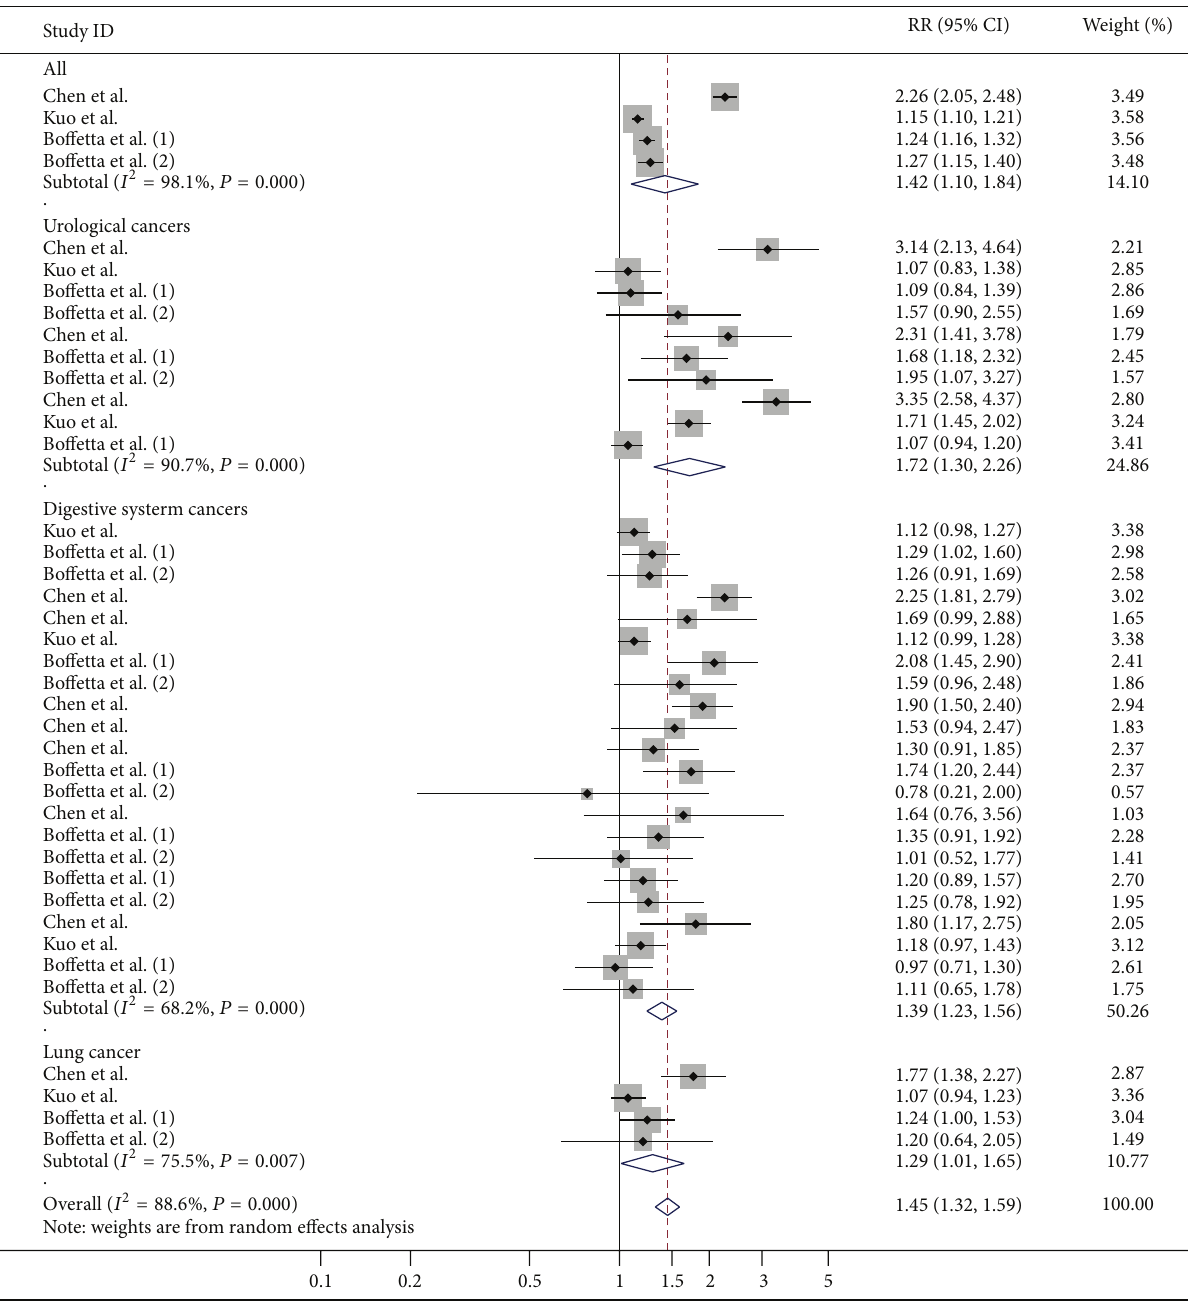
Figure 1: Forest plot for gout and cancer